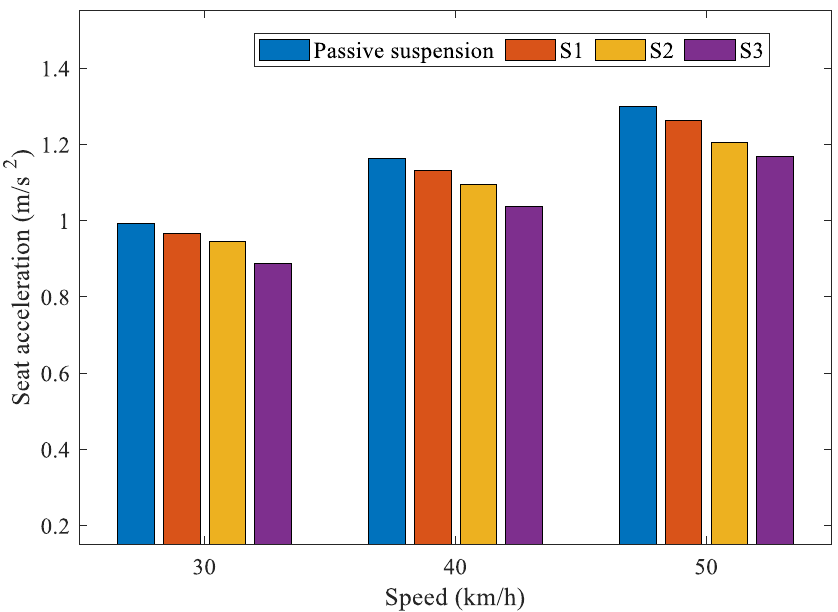
Figure 8. Comparison of the RMS of seat acceleration under different speeds.